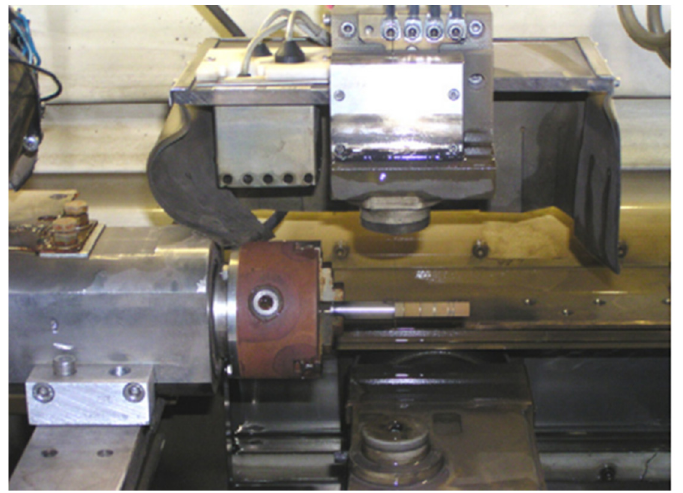
Figure 8. WTET with rotary setup (Reprinted/Adapted with permission from [39]. 2008, Elsevier. ©).